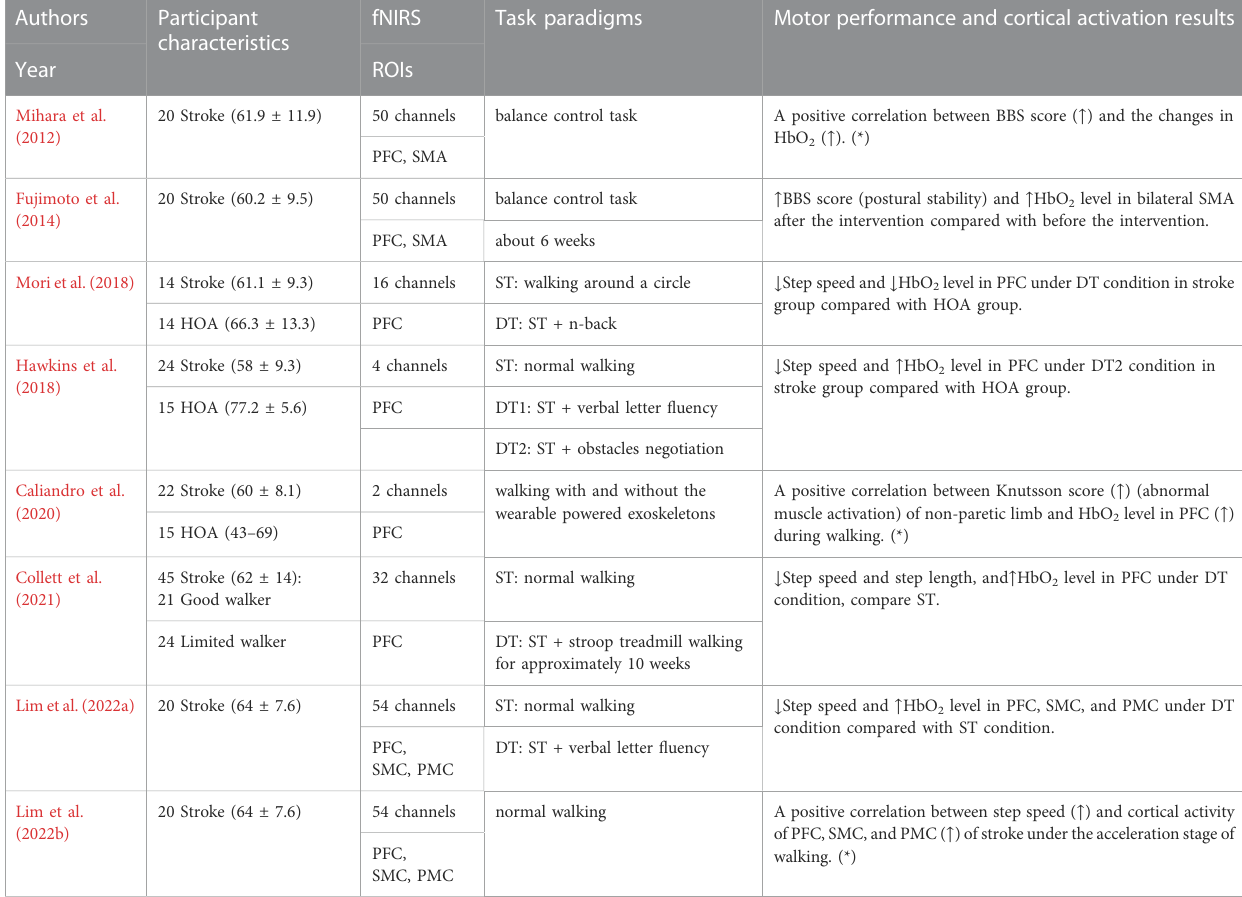
TABLE 2 Summary of motor performance and cortical activation outcomes in studies of stroke